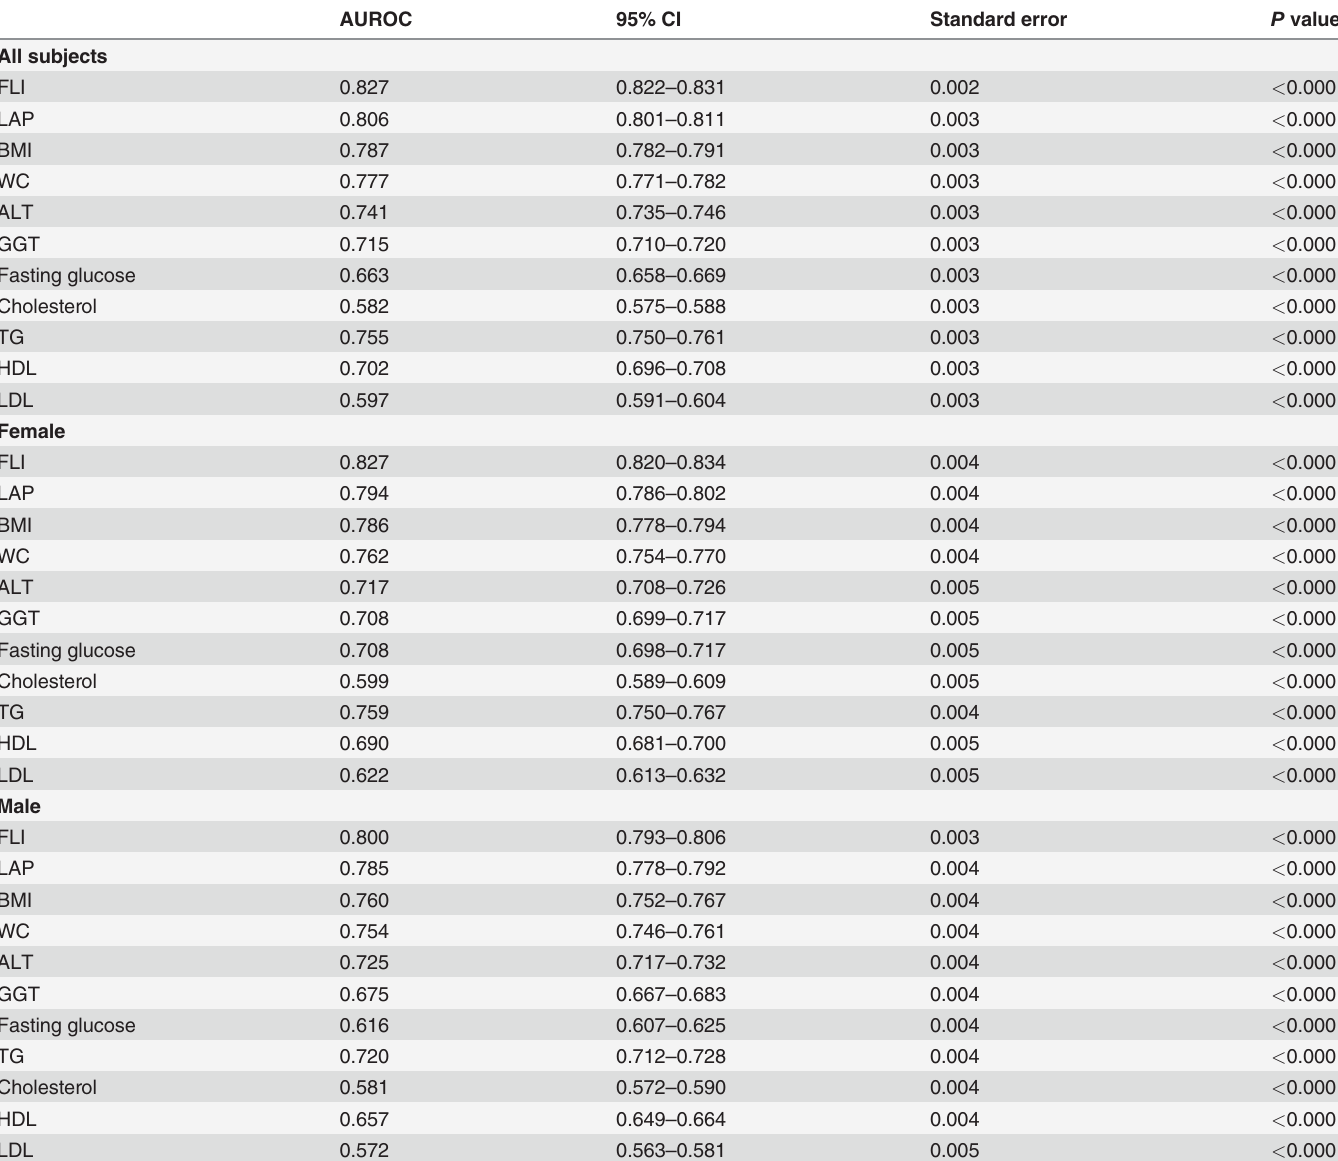
Table 3. Comparison of AUROCs among non-invasive markers for predicting ultrasonogrphic fatty liver. AUROC 95% CI Standard